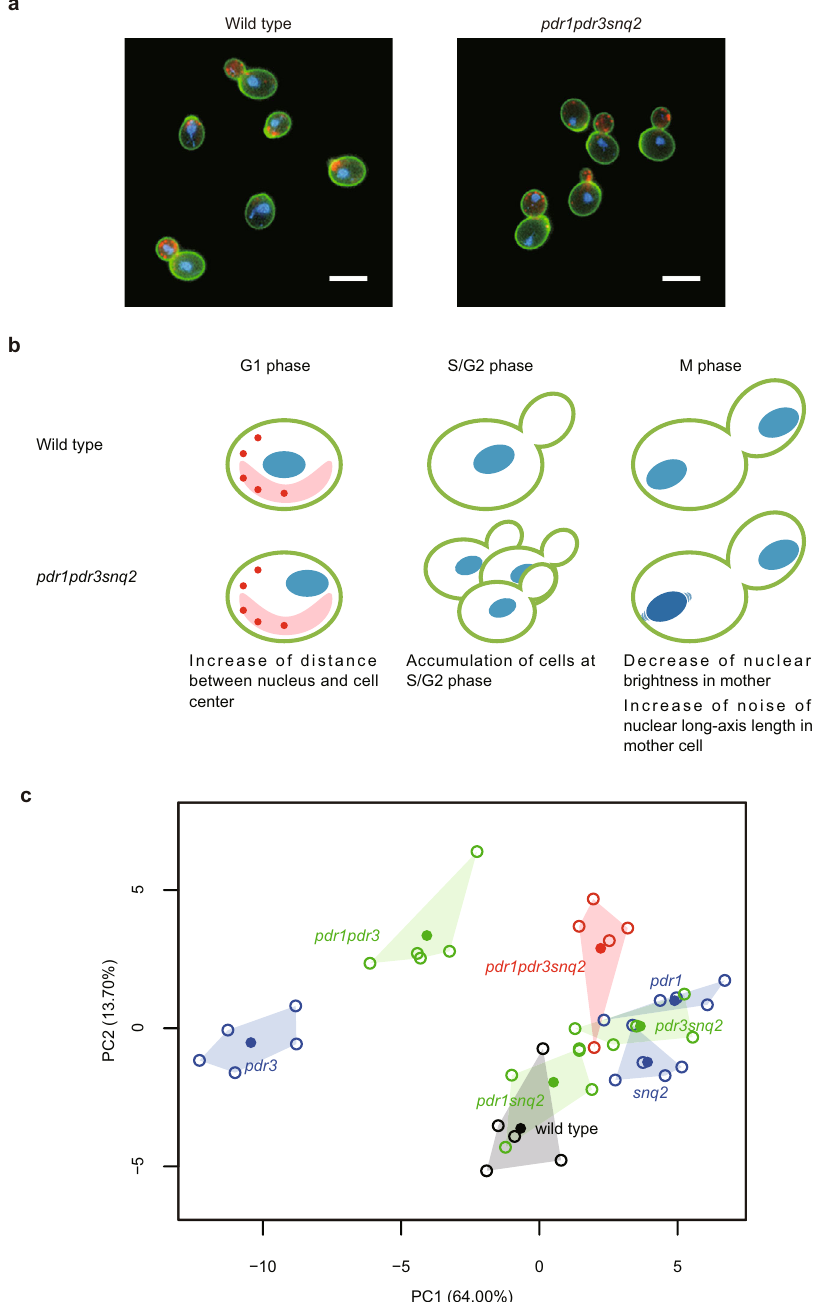
Fig. 2 Morphological phenotype of pdr1 pdr3 snq2 . a Cells of a drug-hypersensitive 3 Δ strain and its parental strain. The cell wall (green), nuclear DNA (blue), and actin cytoskeleton (red) were stained with FITC-ConA, DAPI, and rhodamine-phalloidin, respectively. Scale bars indicate 5 μ m. b Illustration of the morphological phenotype of 3 Δ . Color legend is the same as ( a ). c PCA plot showing the mutual relationship of 3 Δ (red), 2 Δ (green), 1 Δ (blue), and their parental strain (black). Open and closed circles indicate biological replicates ( n = 5) and mean of each